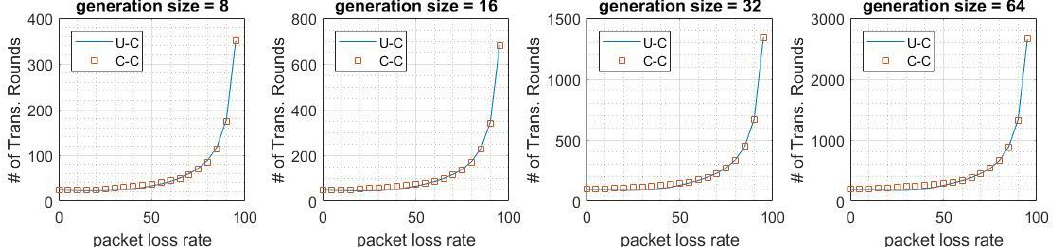
Figure 9. Average number of transmissions in cache coding and unrestricted coding by the simulation results.